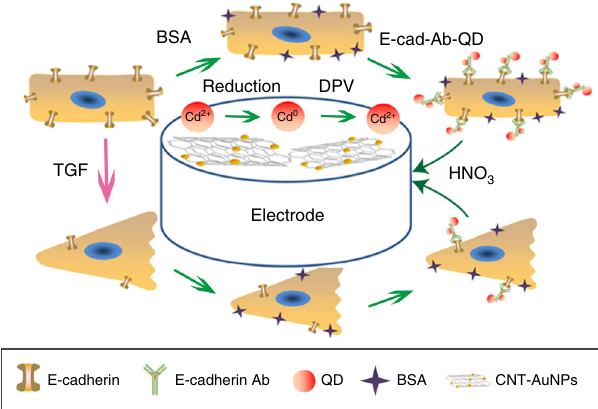
Fig. 8 Construction of the electrochemical biosensor